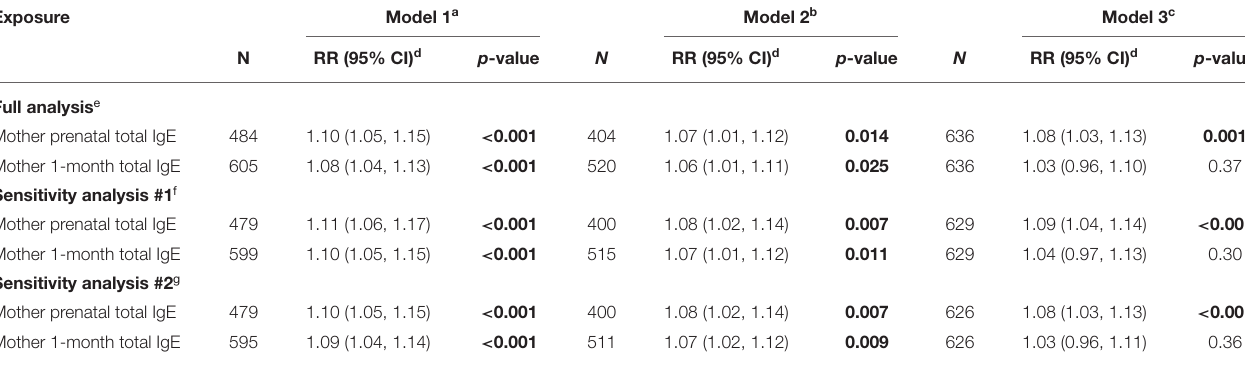
TABLE 3 | Association between the maternal total IgE measurements and ADHD in the offspring.